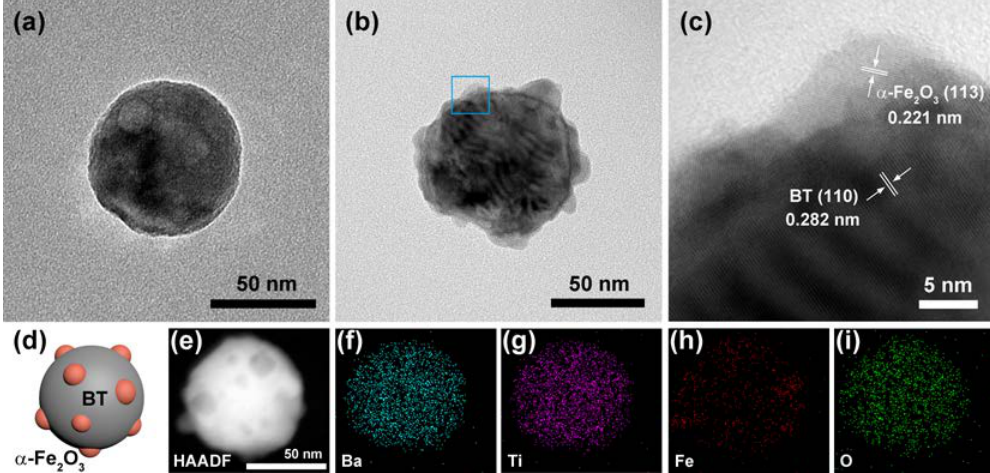
Figure 1. ( a ) Transmission electron microscopy (TEM) photo of a BT nanoparticle. ( b ) TEM and ( c ) HRTEM photos of a Fe 2 O 3 @BT nanoparticle. ( c ) Partially enlarged image of the blue square area in image ( b ). ( d ) Schematic illustration of a Fe 2 O 3 @BT nanoparticle. ( e – i ) HAADF-STEM image with